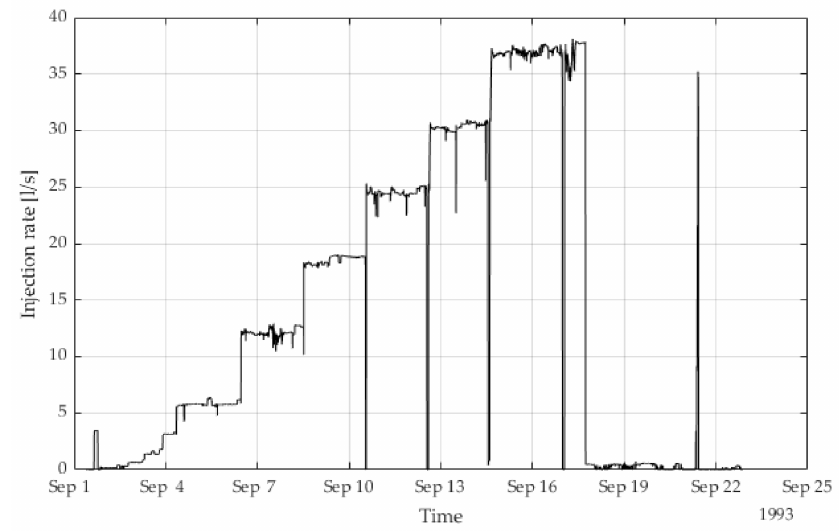
Figure 1. Fluid injection flow rate in GPK-1 Soultz 1993 injection test.